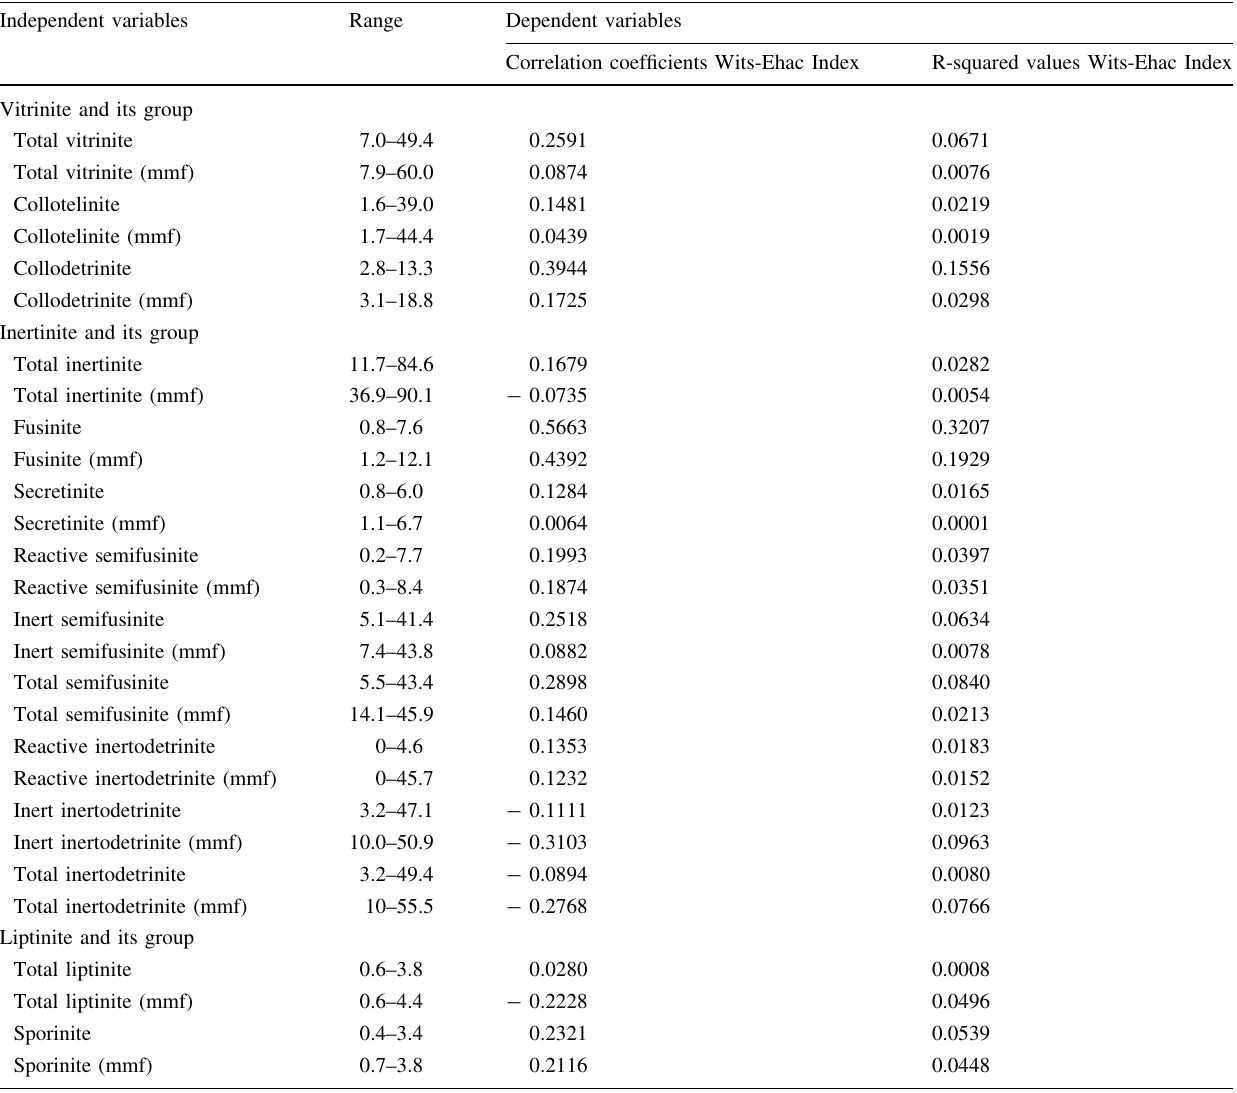
Table 3 Relationships between independent (petrographic analysis, vol%) and dependent variables for the coal samples